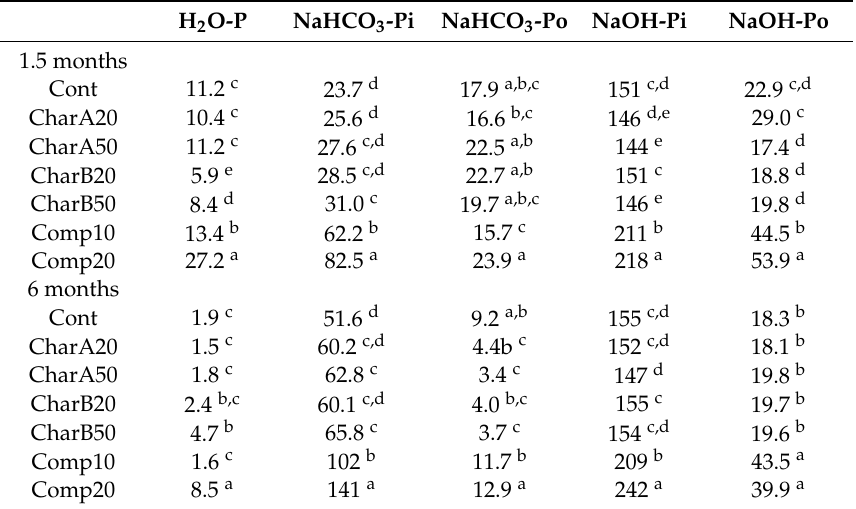
Table 4. E ff ects of di ff erent organic amendments on P contents (mg P kg − 1 ) in di ff erent P fractions in soil after 1.5 months and 6 months of